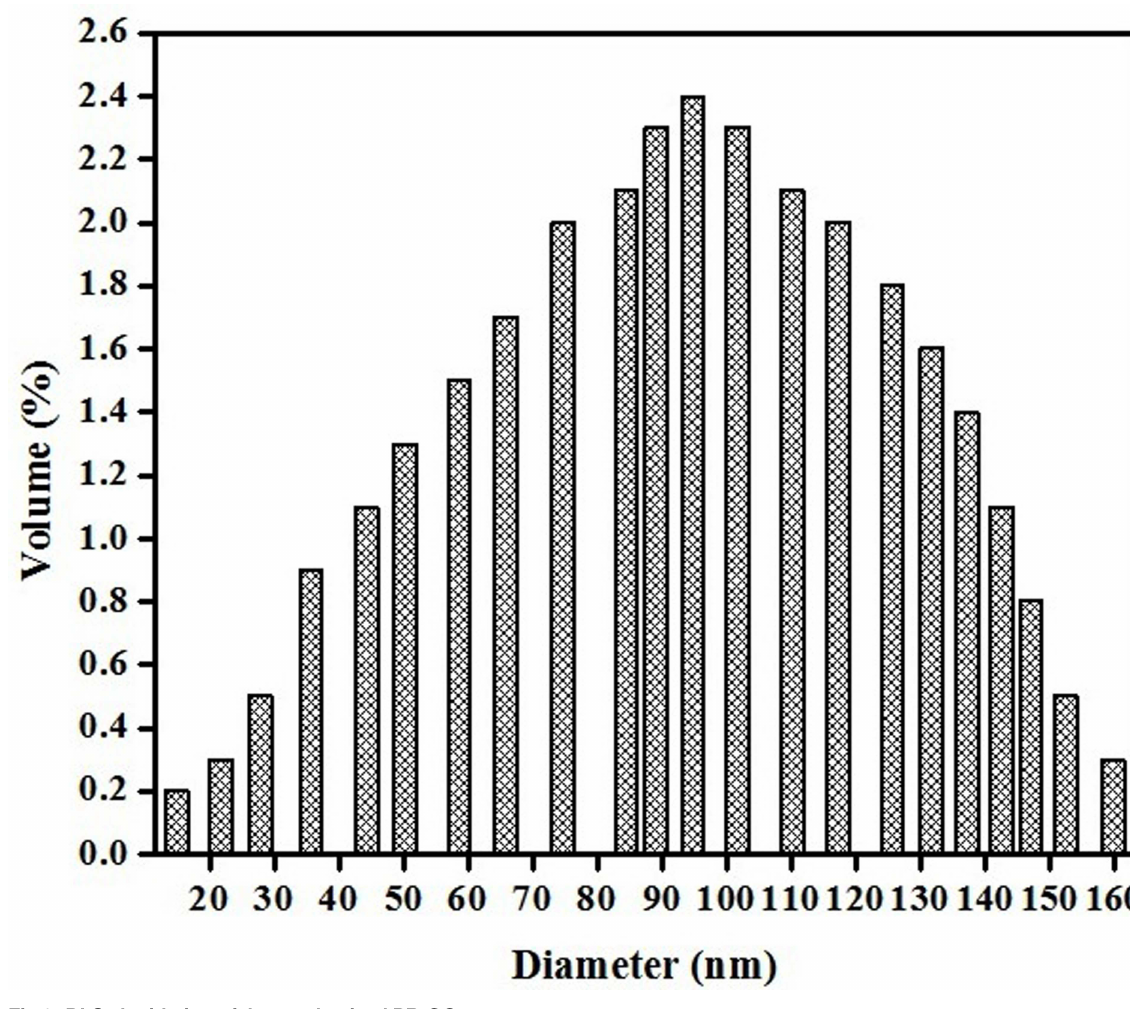
Fig 3. DLS elucidation of the synthesized